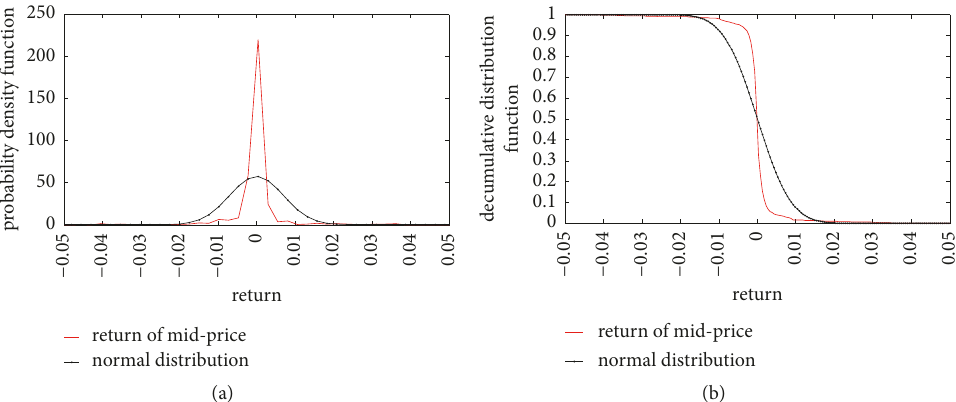
Figure 11: Standard deviation of normal distribution (the std of normal distribution is the same as that of the mid-price return